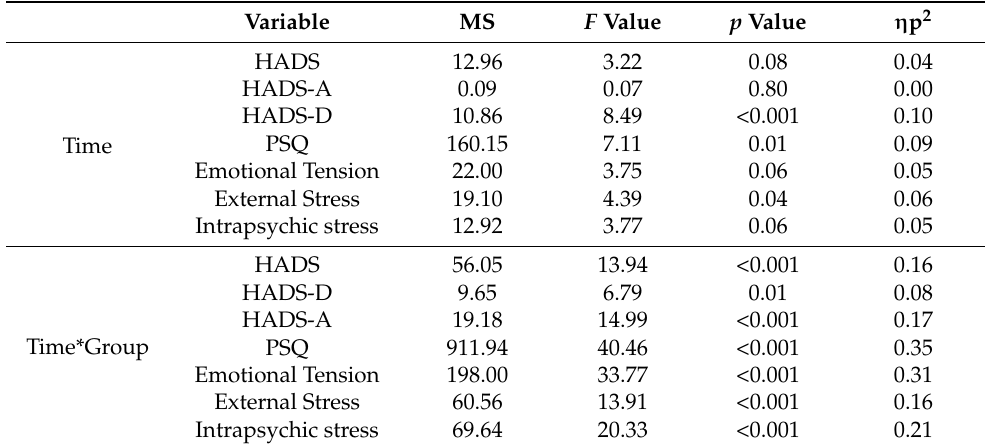
Table 3. Repeated ANOVA